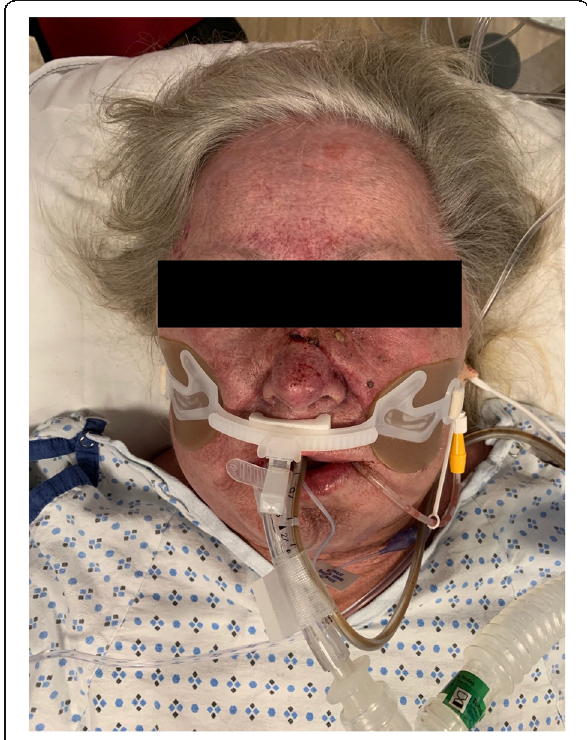
Fig. 1 Patient ’ s clinical appearance after being intubated. Her face is engorged from venous